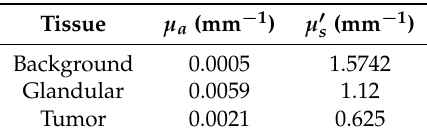
Table 1. Optical properties ( µ a the absorption coefficient, and µ (cid:48) s the reduced scattering coefficient) of different breast tissue at 800 nm.